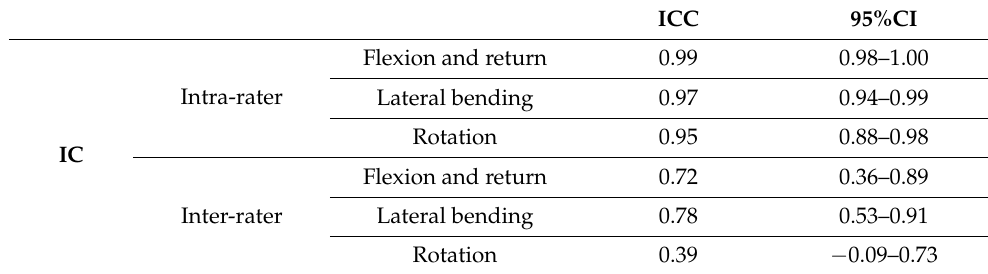
Table 4. Intra-rater and inter-rater reliability.